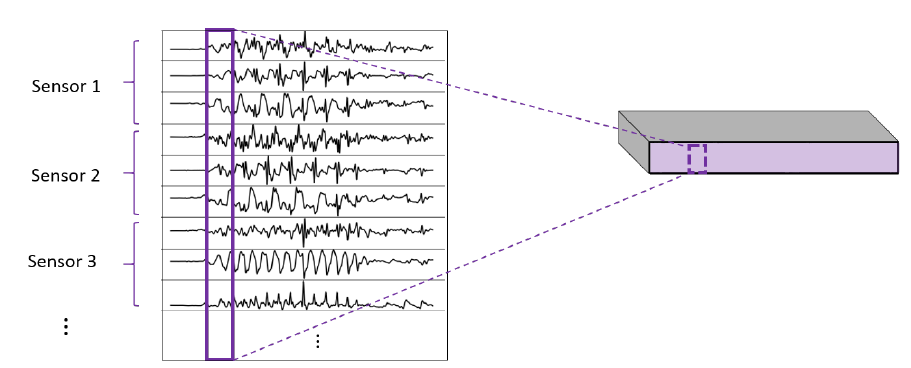
Figure 11. 2DCNN all sensors